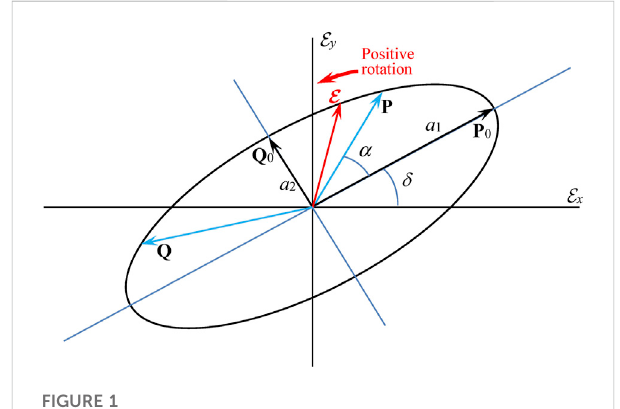
FIGURE 1 “ Polarization ellipse ” (Eq. 2.10) seen against the beam propagation axis z , and its main parameters. During the oscillation period, the end of the instantaneous electric fi eld vector E (Eq. 2.9) (red arrow) slides along the ellipse: anti-clockwise (clockwise) rotation corresponds to the right-hand (left-hand) polarization. The meanings of the parameters a 1 , a 2 , α , δ , P , P 0 , and Q 0 are explained in the